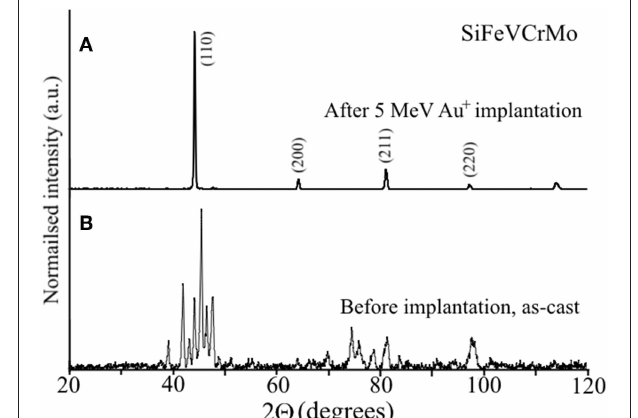
FIGURE 9 | Calculated damage profile, in displacements per atom (dpa), and range of implanted Au 2 + ions, in ions/cm 2 , from SRIM simulation of 5 MeV Au 2 + ion implantation to a fluence of 5 × 10 15 Au ions/cm 2